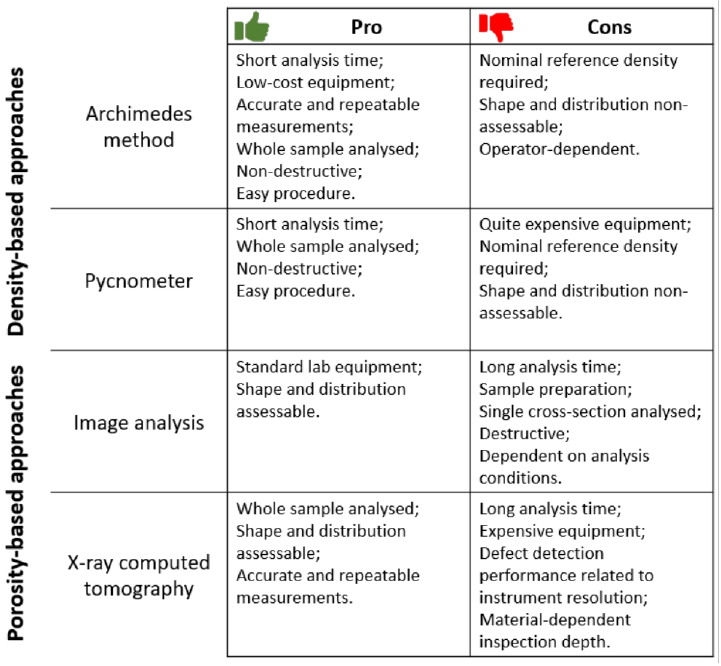
Figure 9. Strengths and weaknesses of the main methodologies for evaluating the level of densifica- tion achieved in PBF-LB/M